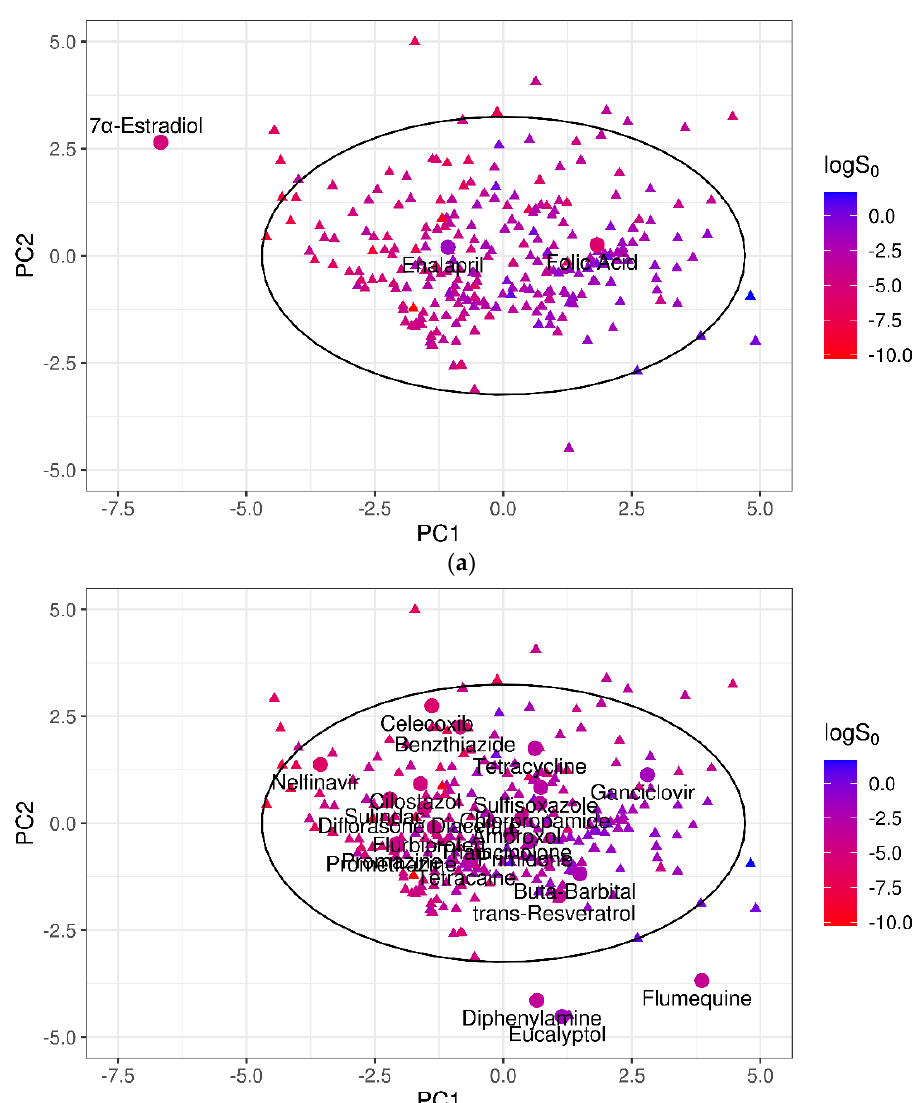
Figure 6. ( a ) Projection of the three worst-predicted outliers of test set 1 in the PC1–PC2 dimensional space. ( b ) Projection of the 22 best-predicted compounds of test set 1 in the PC1–PC2 dimensional space. Circles mark the test compounds; triangles represent the 270 training molecules; and the black solid ellipse marks the 95% CI of the training domain. For both training and test compounds, solubility value is represented by color.